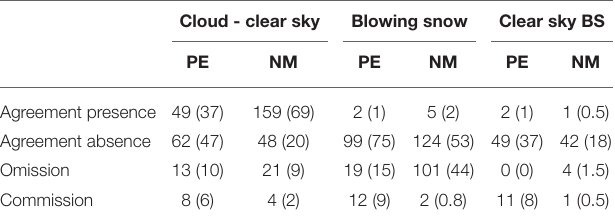
TABLE 3 | Overview of the agreement between ceilometer and satellite detections at the Princess Elisabeth (PE) and Neumayer (NM) stations. Cloud - clear sky Blowing